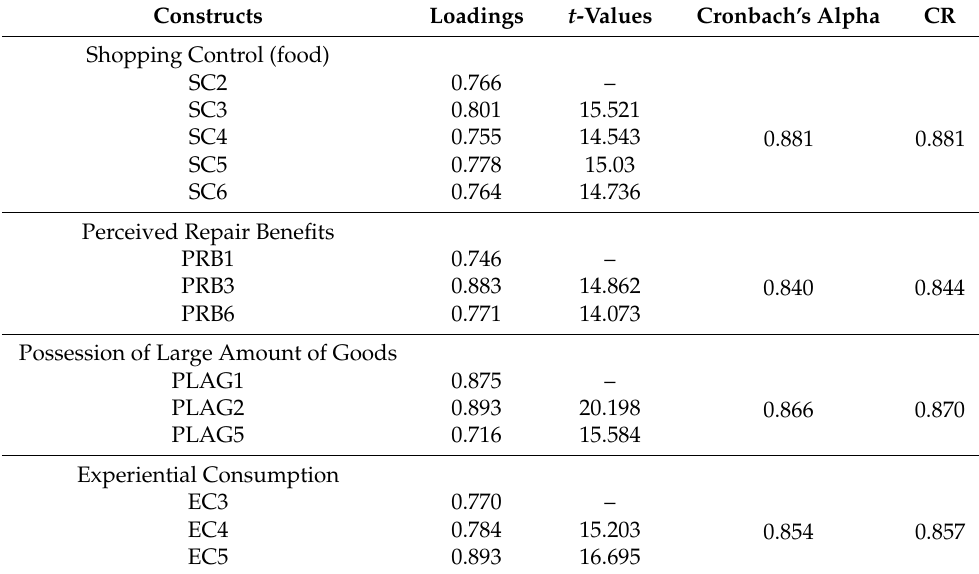
Table 7. Construct reliability analysis.